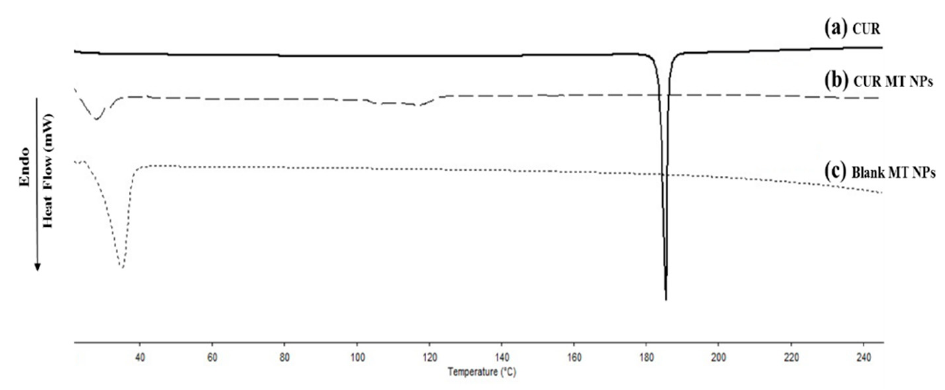
Figure 4. D ifferential scanning calorimetry (DSC) analysis of ( a ) CUR, ( b ) CUR MT NPs, and ( c ) blank MT NPs.